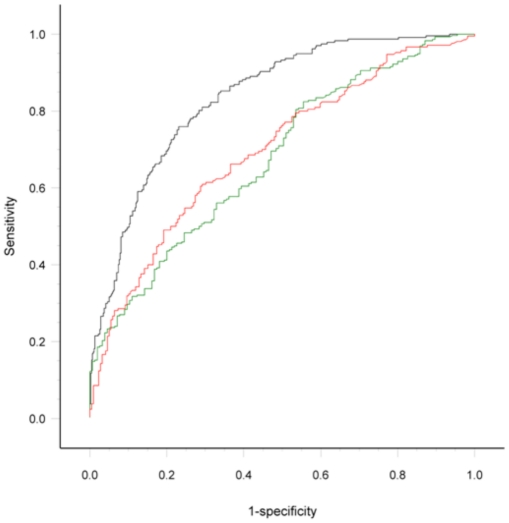
Receiver operating characteristic curves of the final nomogram model in the Netherlands (black), Vietnam (red), and Malawi (green).